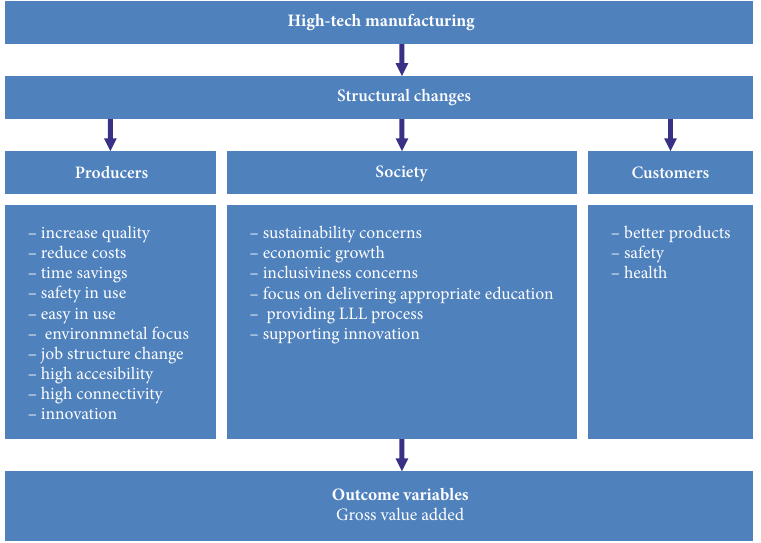
Figure 1. Analyzed transmission channels